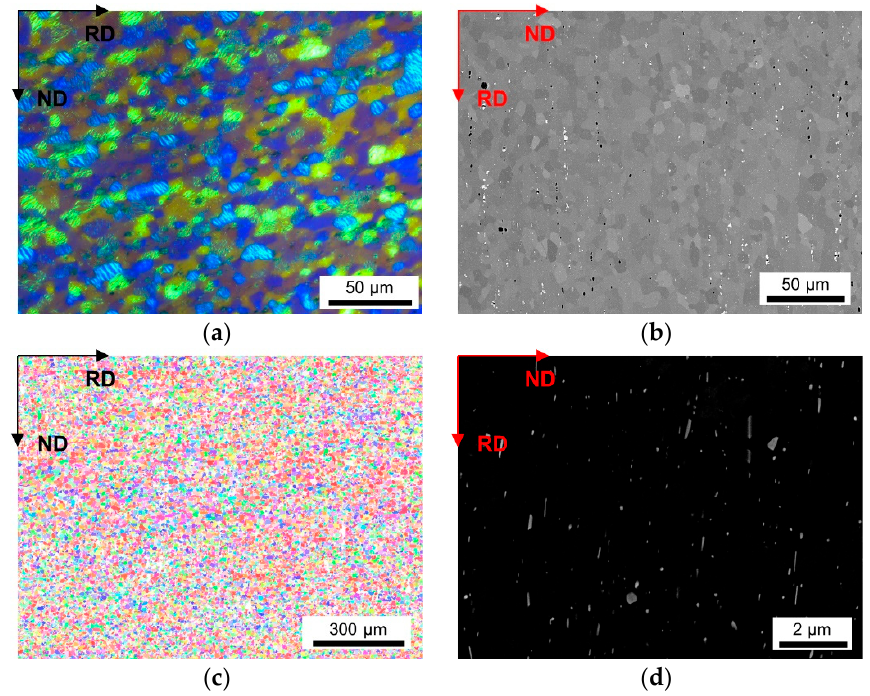
Figure A11. Microstructure of the soft annealed LFe-HMn cast under NR-C conditions, homogenized at 500 °C and cold rolled to a CRD of 63%. ( a ) LOM. ( b ) BSE image. ( c ) EBSD IPF map in RD–ND plane. ( d ) BSE micrograph showing dis- persoids.